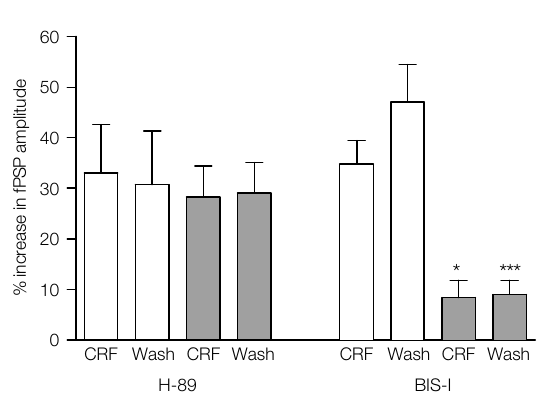
Figure 7 | The effect of CRF (0.1 μ M) on the amplitude of fPSPs evoked in control slices or slices that had been incubated with the protein kinase inhibitors, H-89 (10 μ M; 7 slices from 5 rats per group) or BIS-I (1.2 μ M; 7 slices from 4 rats per group). Control slices were obtained from the same rats as slices incubated with one or other of the inhibitors. Data shown are the mean ± SEM. * p < 0.05, *** p < 0.001, one-way ANOVA followed by Bonferroni comparison vs. the respective